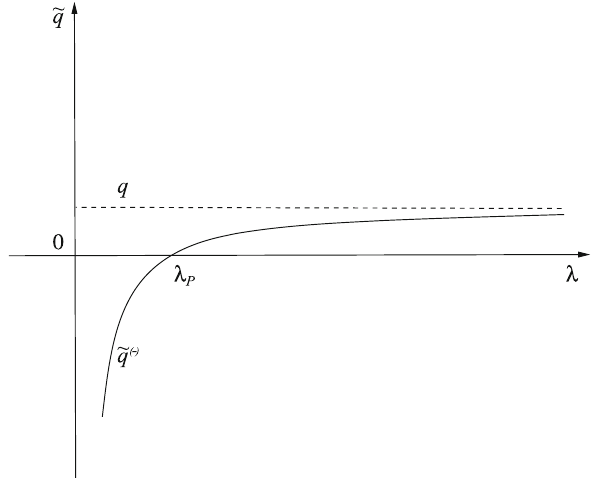
Fig. 2 The deceleration parameter ( ˜ q ( − ) ) measured in the frame of a slowly contracting bulk flow with peculiar Jeans length λ P (see Eq. (20)). On large scales, far away from the observer, ˜ q ( − ) approaches the deceleration parameter of the Einstein-de Sitter background (hori- zontal dashed line). In other words, ˜ q ( − ) → q = 1 / 2 when λ (cid:8) λ P . On the other hand, as we move closer to the observer, the local decelera- tion parameter starts to diverge, dropping below the ˜ q ( − ) = 0 mark and turning negative at the transition scale ( λ P ). Note that we have assumed that ˜ ϑ = const. and normalised so that λ P = 1